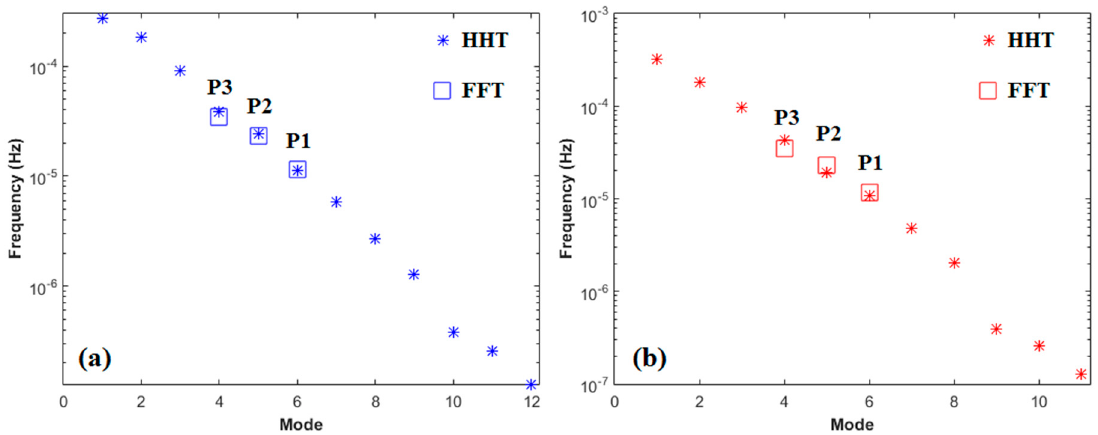
Figure 8. HHT-EMD (stars) and FFT (square) frequencies related to a restaurant user for ( a ) the active power and ( b ) the reactive power.